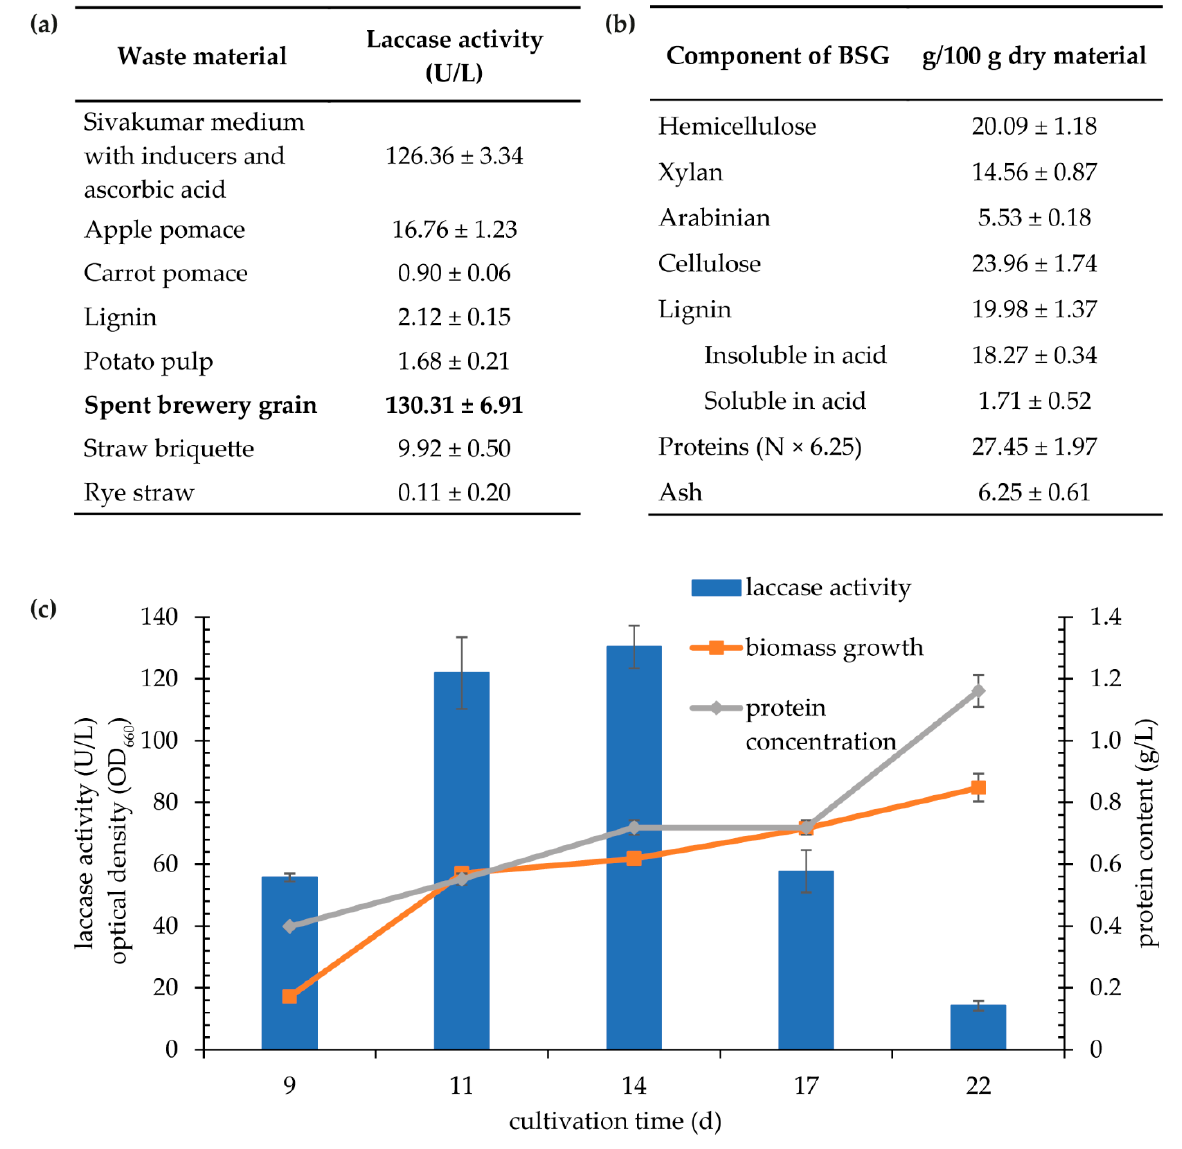
Figure 7. Cultivation of K. bupleuri G3 with waste materials. ( a ) Laccase activity after cultivation in Sivakumar media (without the presence of additional inducers) enriched with various waste products at a concentration of 100 g/L (the maximum activity with brewery spent SG) is shown in bold); ( b ) chemical composition of ; ( c ) growth, protein content and extracellular laccase activity during cultivation in Sivakumar medium with 100 g/L of BSG.